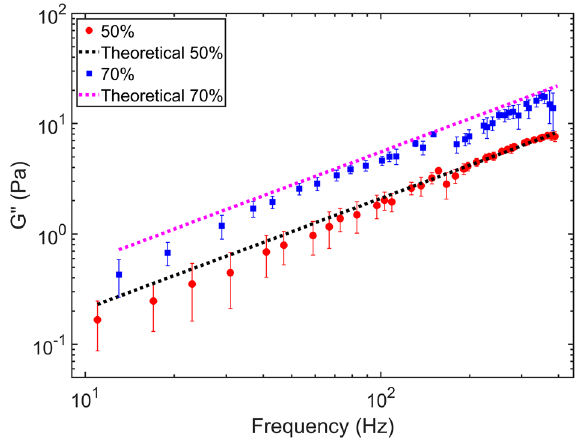
Figure 3. Imaginary part of complex modulus of the glycerol-water solution as a function of the driving frequency estimated by using the multi-frequency APC technique. The loss modulus of glycerol-water solutions scale as G ′′ ∼ f 1 . Dotted lines show the theoretical values calculated using the Stoke’s law for spherical particles for two different concentrations 50% and 70% .